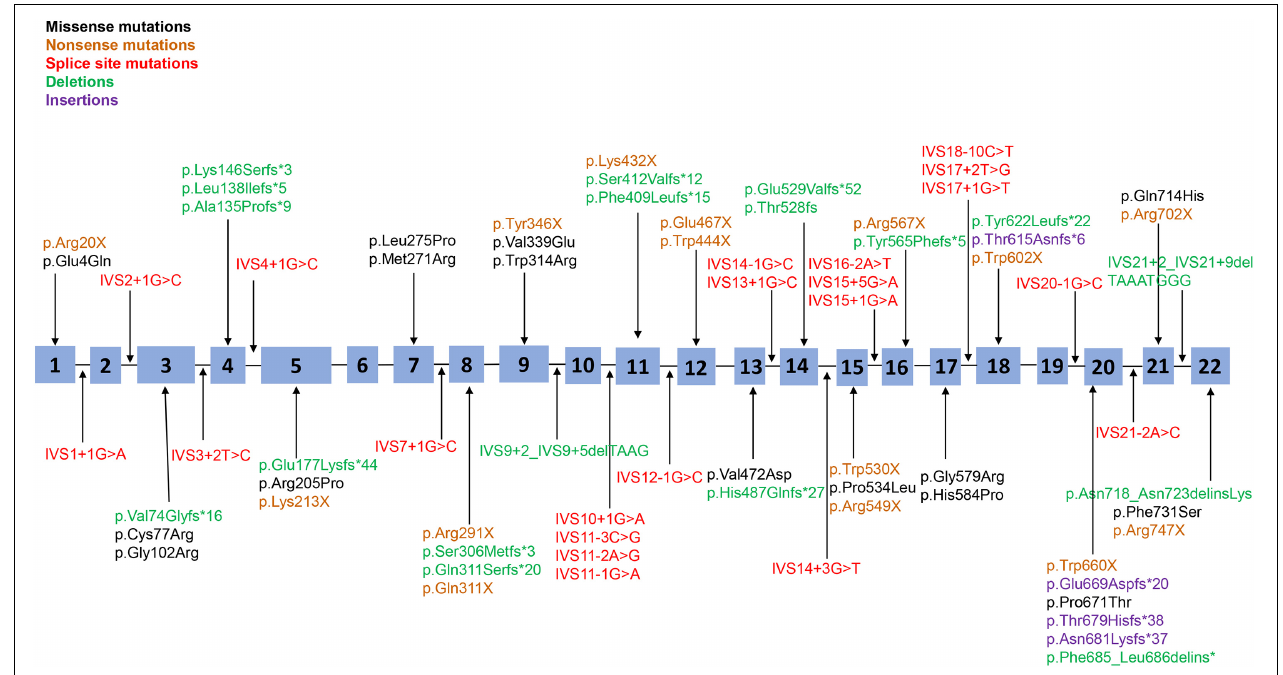
FIGURE 1 | Distribution of all point mutations identified in this study. A total of 73 point mutations (including missense mutations, non-sense mutations, splice-site mutations, and small insertions/deletions) were scattered throughout the 22 exons and adjacent intron areas of the PHEX gene. Black corresponds to missense mutations, yellow corresponds to non-sense mutations, red corresponds to splice-site mutations, green corresponds to small deletions, and purple corresponds to small insertions.